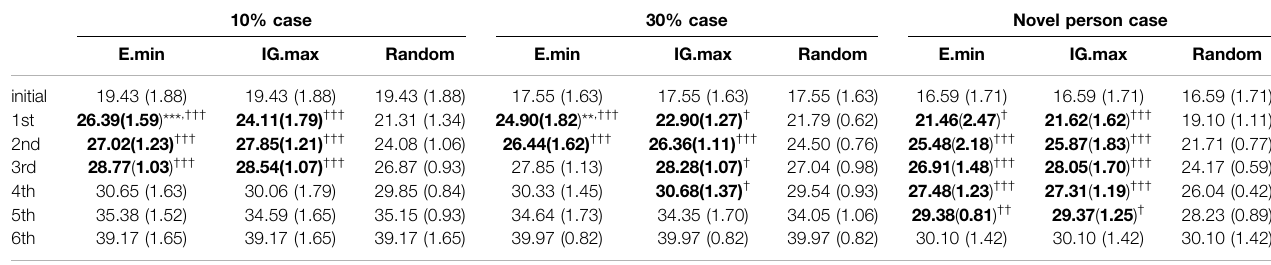
TABLE 3 | Change in estimation accuracy mean and standard deviation through each active perception method in all dataset cases. The values in parentheses indicate the standard